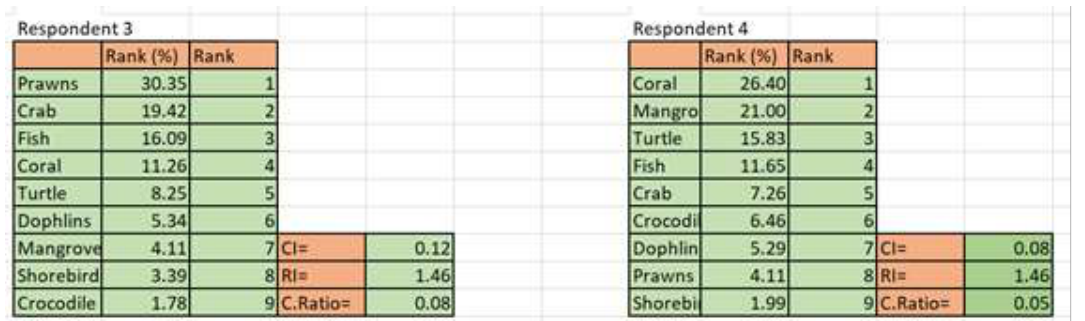
Table 3: Priority ranking of marine resources based on experts 1 and 2’s perspectives Table 3: Prioritization of marine resources at risk by experts 1 and 2